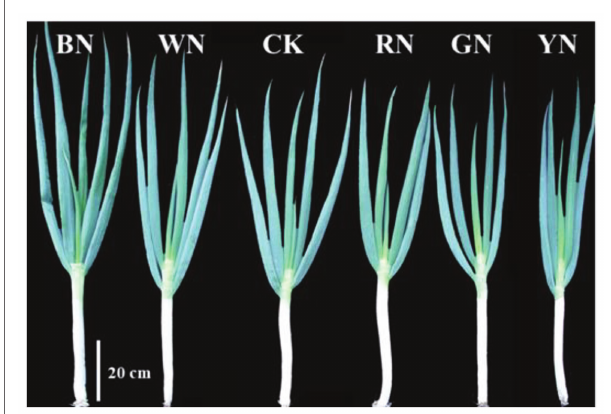
TABLE 3 | Effect of photo-selective nets on the yield of green onion.